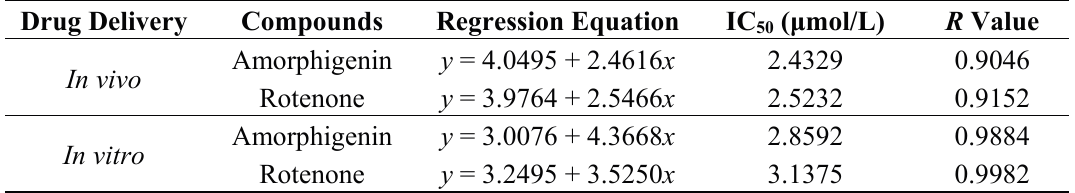
Table 1. The in vivo and in vitro inhibition of amorphigenin and rotenone against the mitochondrial complex I of Cx. pipiens pallens